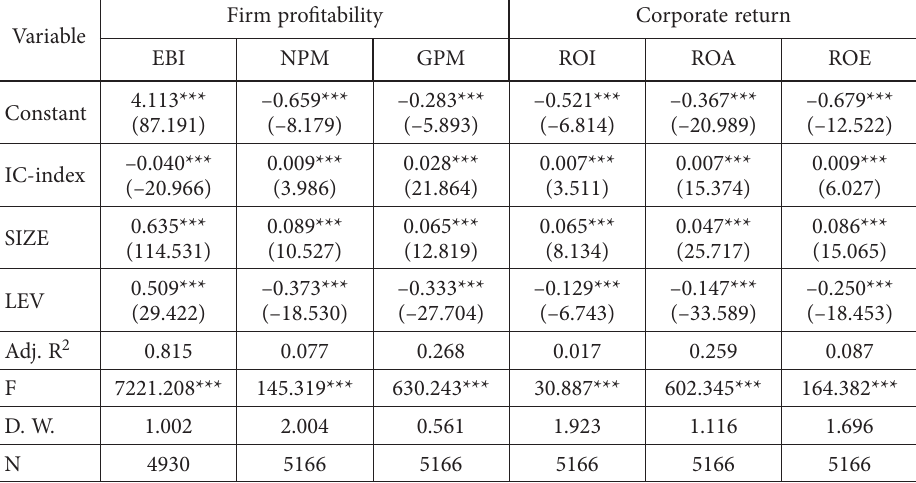
Table 6. Regression results of Model